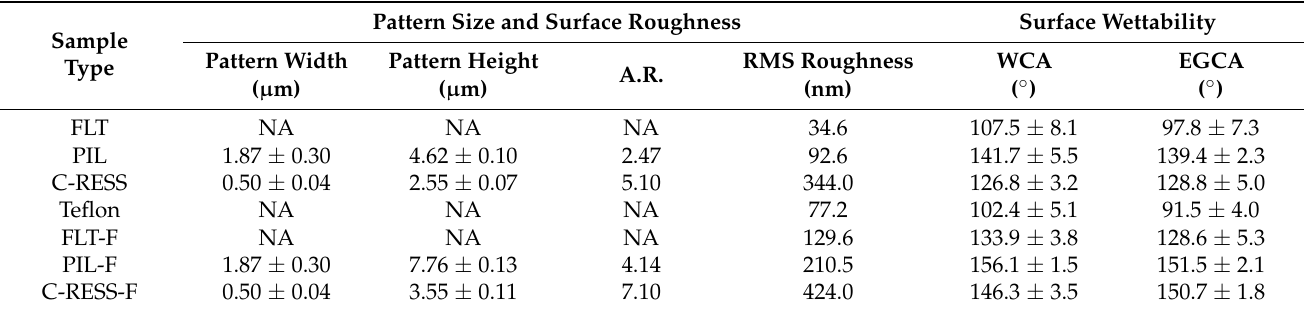
Figure 8. The effects of micro-structure geometry and the flame treatment process on the hydrophobic properties. Table 1. Summary of the measured pattern size, surface roughness, WCA, and EGCA of various PDMS patterns and Teflon surfaces before and after flame treatment process for 15 s.